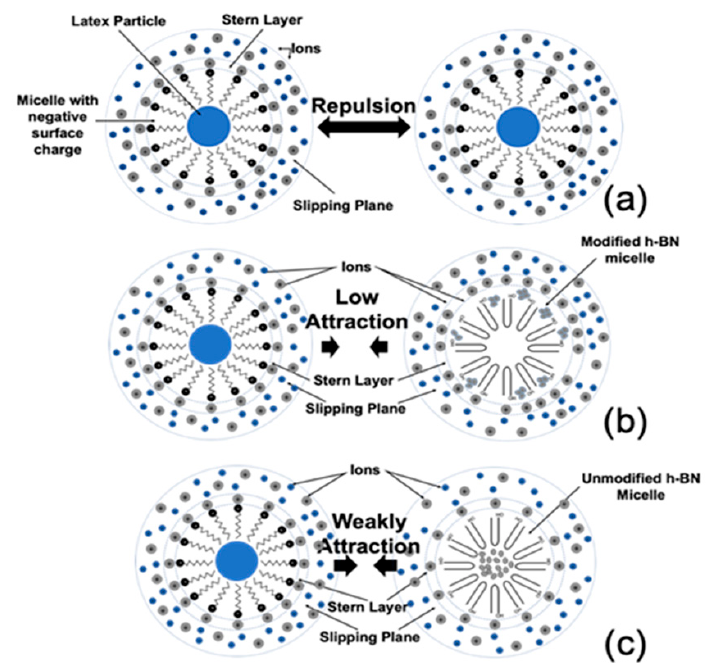
Figure 6. Scheme of possible Z potential behavior explanation between the di ff erent colloidal systems. ( a ) Emulsion (micellar) acrylic resin, ( b ) emulsion and modified h-BN micelle, and ( c ) emulsion and unmodified h-BN micelle.